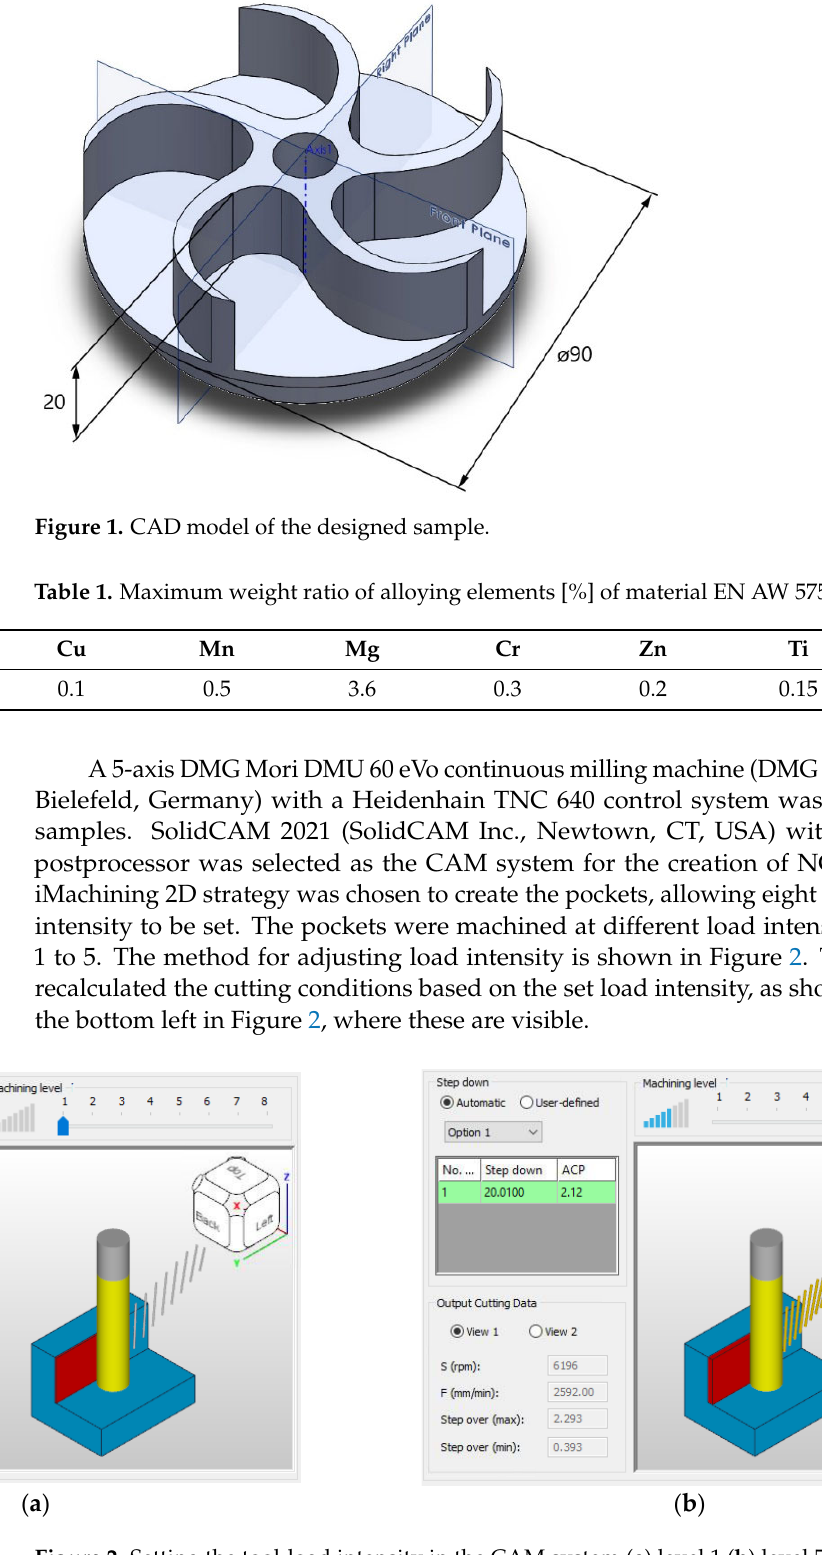
Figure 2. Setting the tool ‐ load intensity in the CAM system ( a ) level 1 ( b ) level